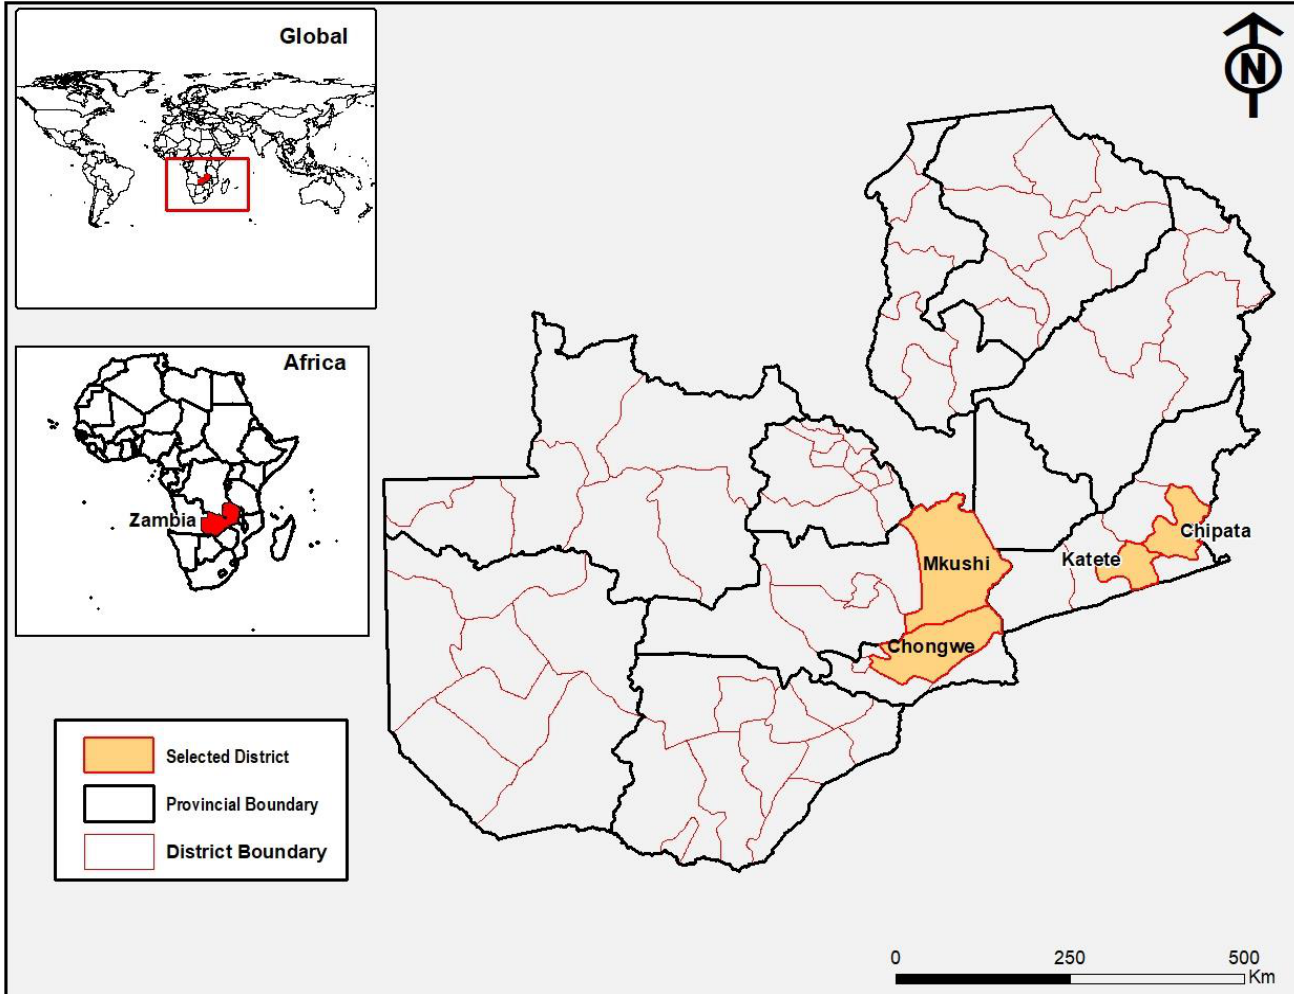
Figure 1. Map showing the study area.